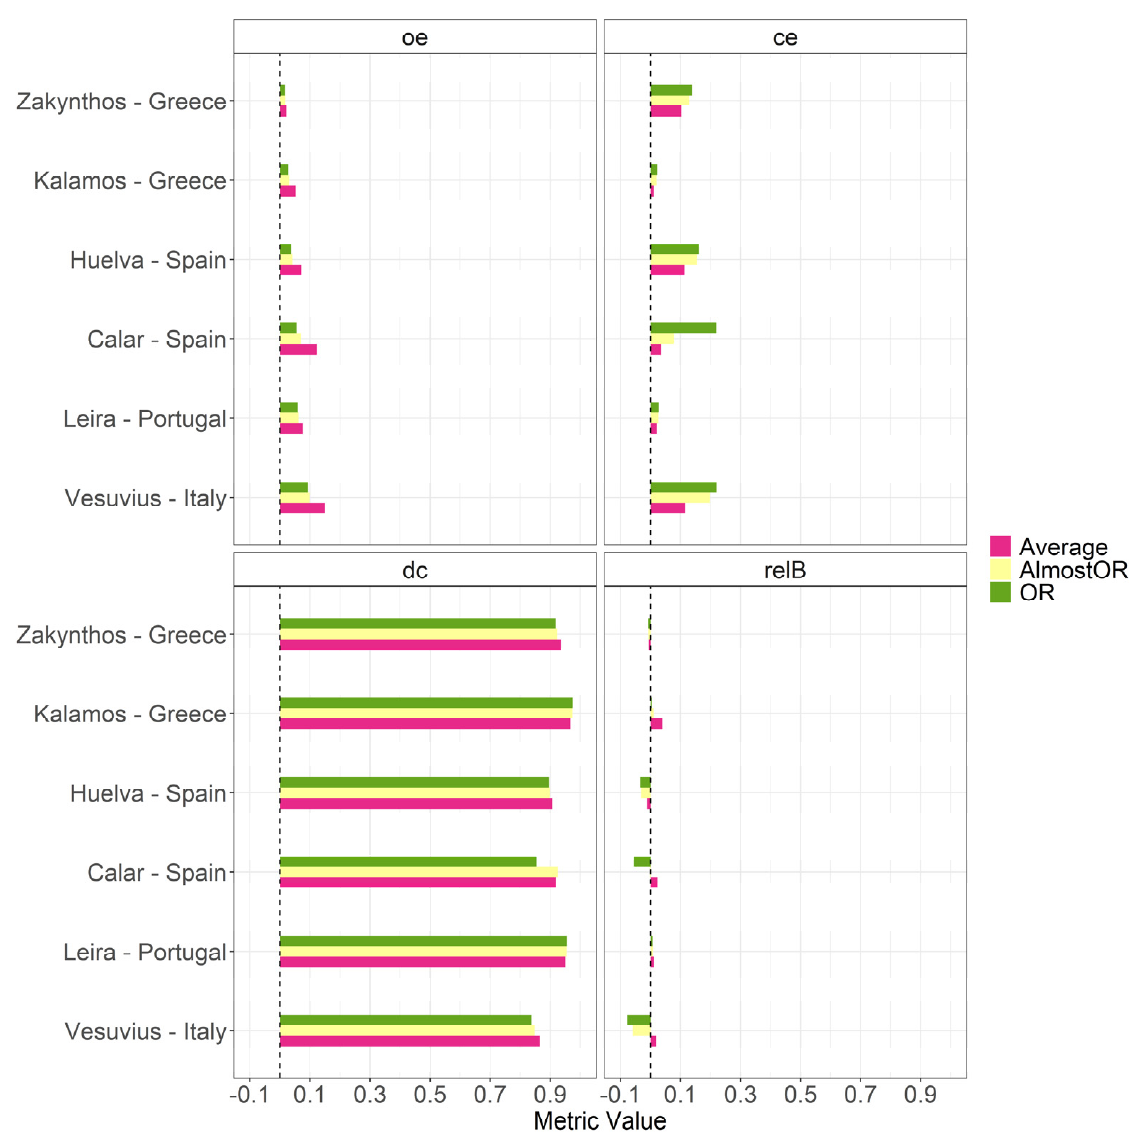
Figure 9. Agreement maps obtained for OWA Average (left column), OWA AlmostOR (middle column) and OWA OR (right col- umn) over exportability sites: Leiria, Portugal ( a – c ), Calar, Spain ( d – f ), Huelva, Spain ( g – i ), Kalamos, Greece ( l – n ) and Zakynthos, Greece ( o – q ). The four classes represent: correctly classified burned pixels (orange), correctly classified un- burned pixels (white), pixels mistakenly classified as burned—commission (blue) and pixel mistakenly classified as un- burned—omission (green).